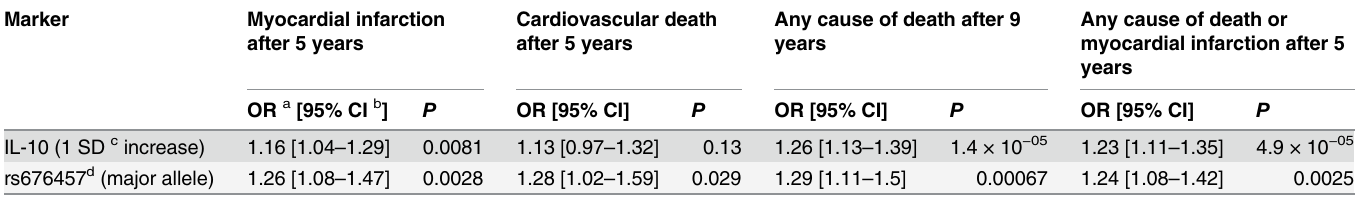
Any cause of death or myocardial infarction after 5 years